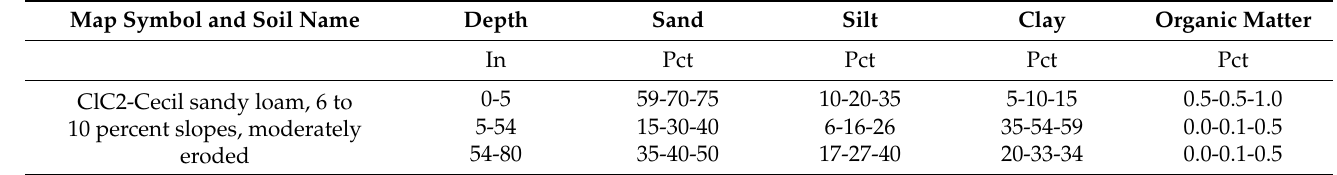
Note: Three values are provided to identify the expected Low (L), Representative (R), and High (H).